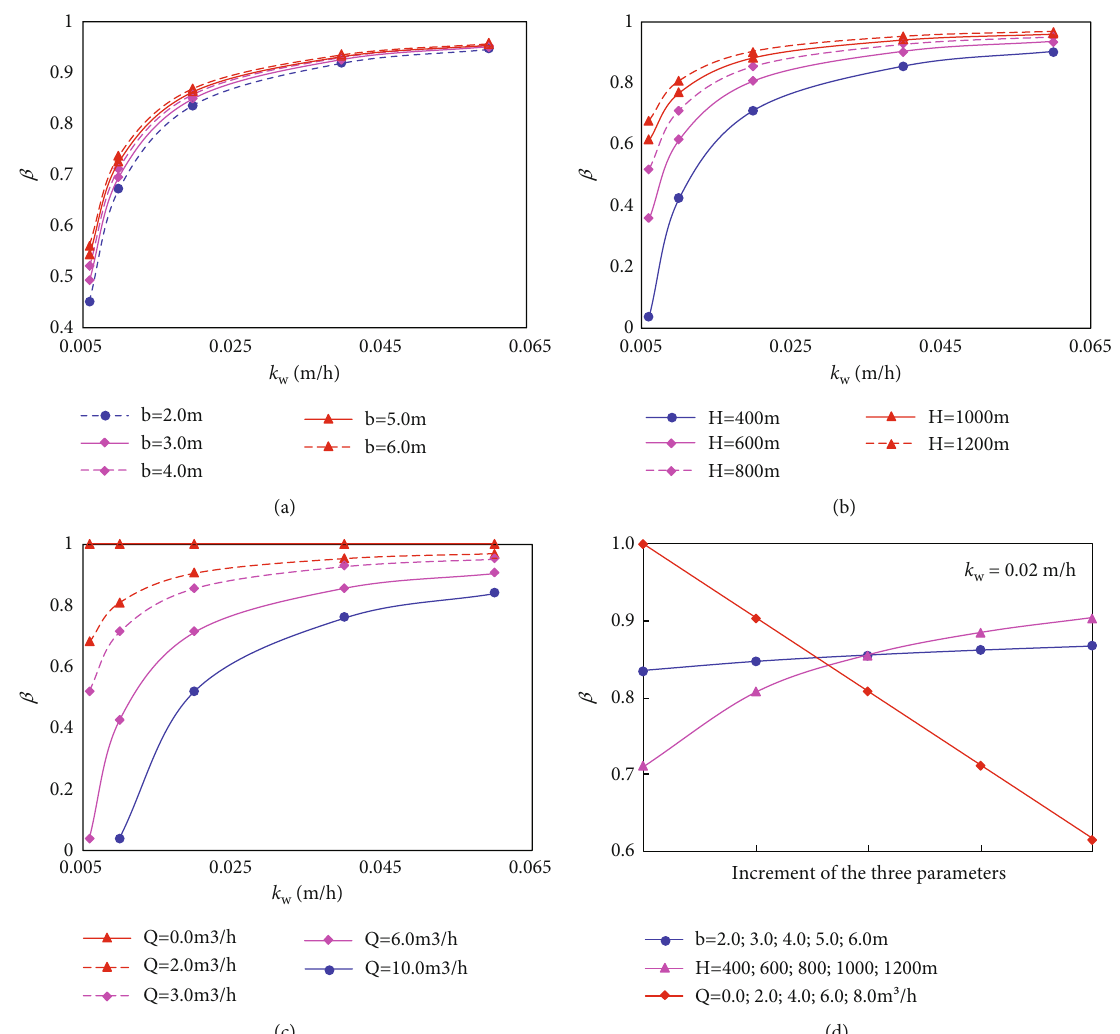
Figure 5: Variation of shaft lining water pressure reduction coe ffi cient with the permeability of surrounding rock: (a) variation of b ; (b) variation of H ; (c) variation of k ; (d) comparison of three w